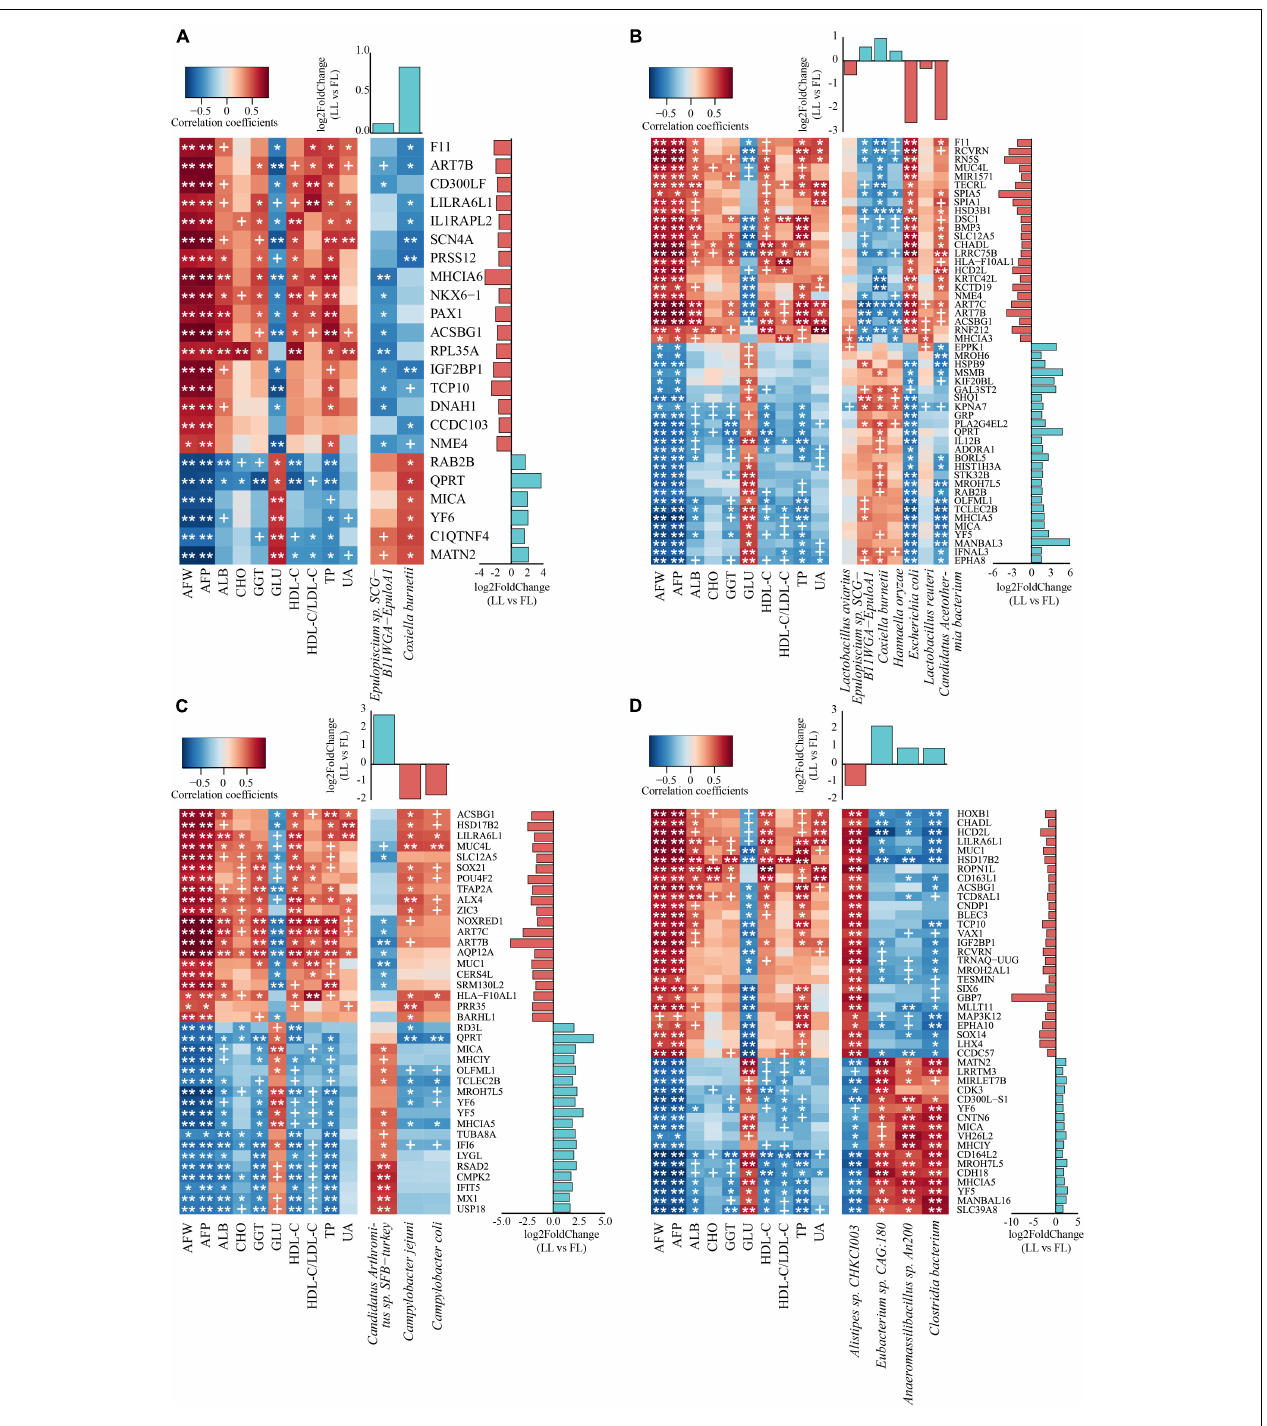
FIGURE 5 | Multi-omics correlation analysis reveals the interactions between microbiome and host. Each heat map contains two parts: the correlations between gene expression and abdominal fat relevant traits (left part of each panel) and correlations between gene expression and microbial relative abundance (right part of each panel). For each tissue compartment, the genes shown had significant correlations and were DEG in the transcriptome analysis. The upper histogram shows the log2FC of microbial relative abundance between the two lines, while the right histogram displays the log2FC of gene expression [lean line (LL) vs. fat line (FL)]. In the histograms, the light blue and orange columns represent genes or microbes significantly enriched in the lean- and fat-line broilers, respectively. The significance p -value threshold was set to 0.05 in the small intestine (A–C) and 0.01 in the ceca (D) . ALB, albumin; CHO, total cholesterol; GGT, γ -glutamyl transpeptidase; GLU, glucose; HDL-C, high-density lipoprotein cholesterol; LDL-C, low-density lipoprotein cholesterol; TP, total protein; UA, uric acid. + p -value < 0.1; * p -value < 0.05; ** p -value < 0.01. AFW, abdominal fat weight; AFP, abdominal fat percentage. (A) Duodenum; (B) jejunum; (C) ileum; (D) ceca.